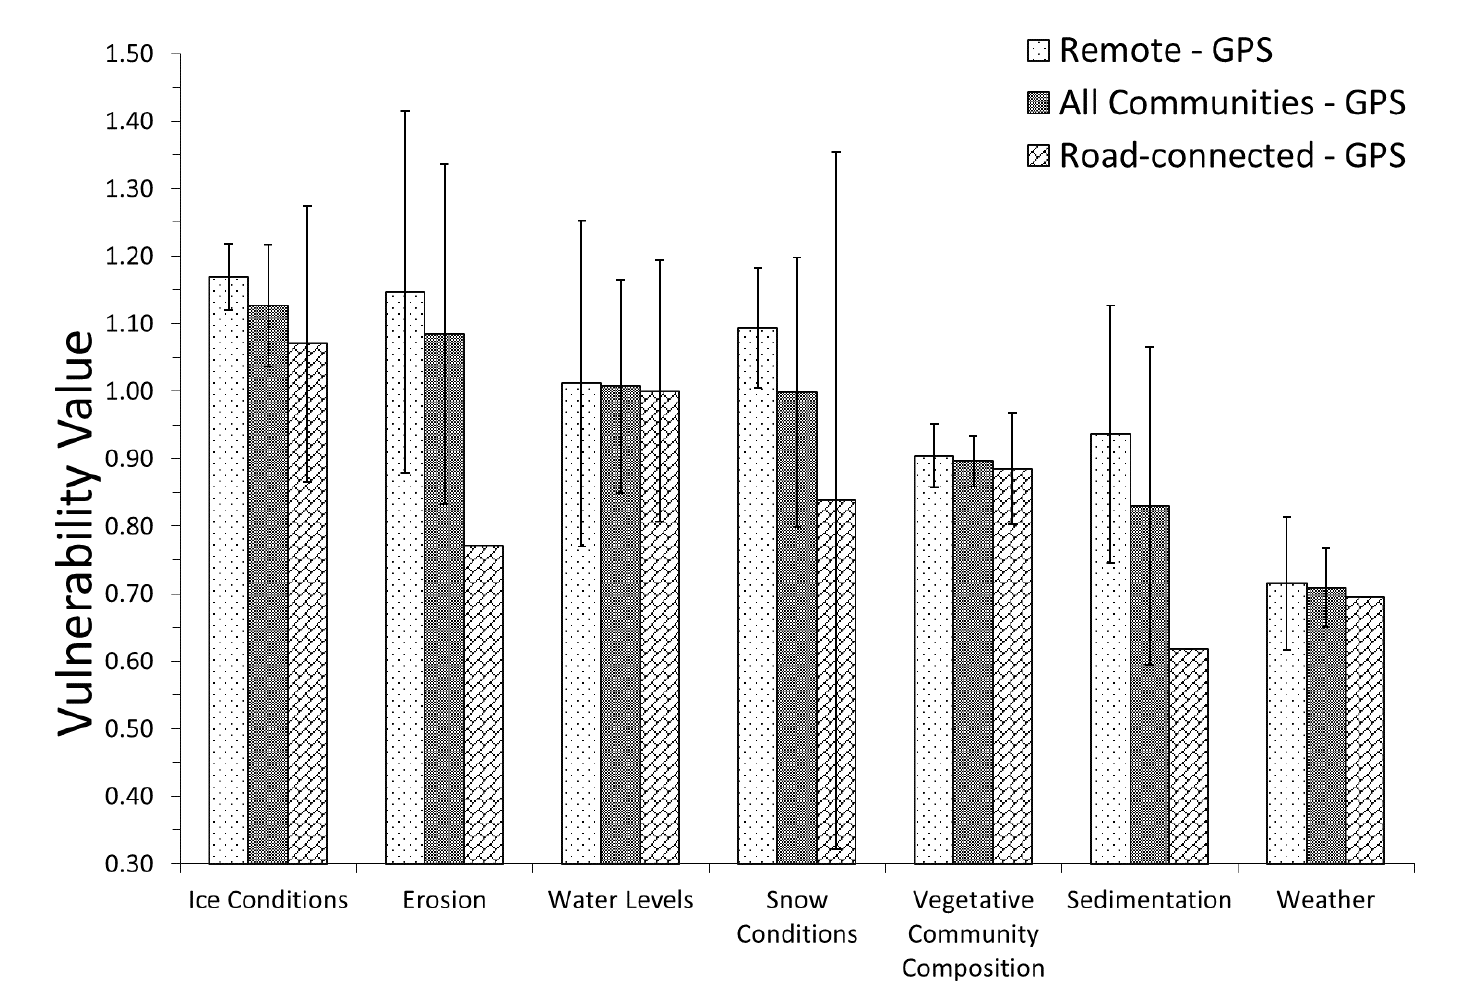
Figure A3.1. Graph comparing vulnerability values and associated margins of error for environmental conditions from GPS data among remote communities, road-connected communities and all communities